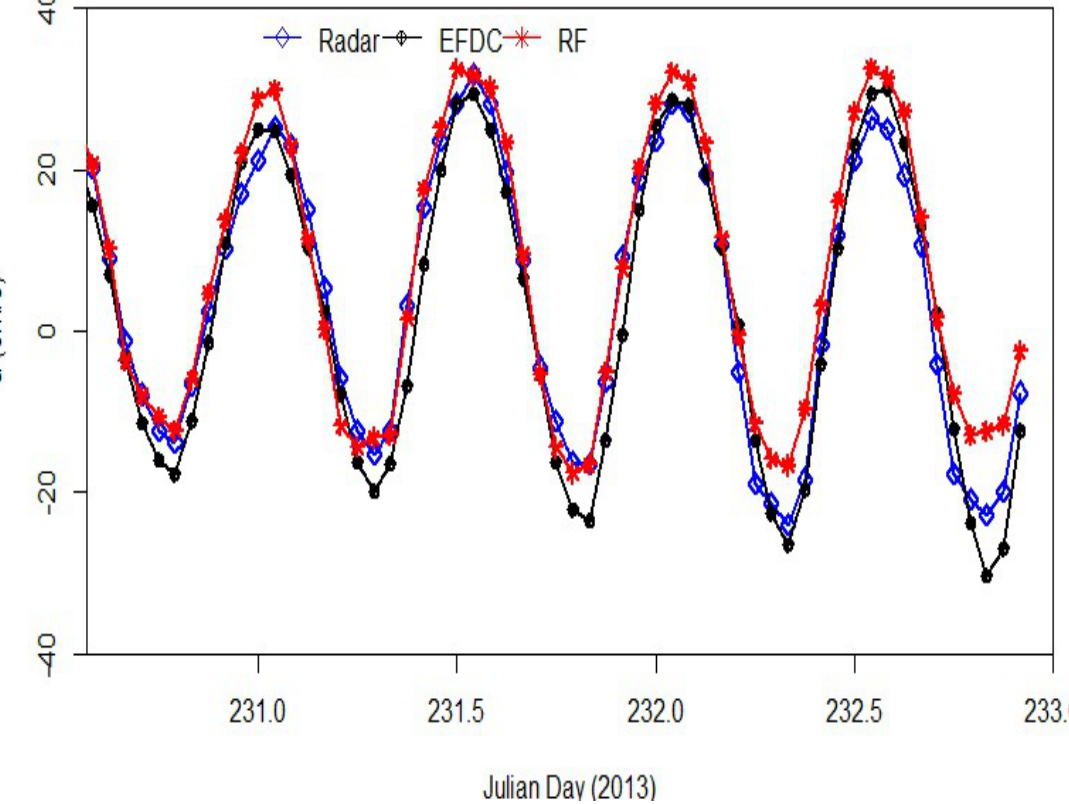
J. Mar. Sci. Eng. 2019 , 7 , x FOR PEER REVIEW Figure 5. Predictions of zonal surface velocity component at point P2. Figure 3. Predictions of zonal surface velocity component at point P1.